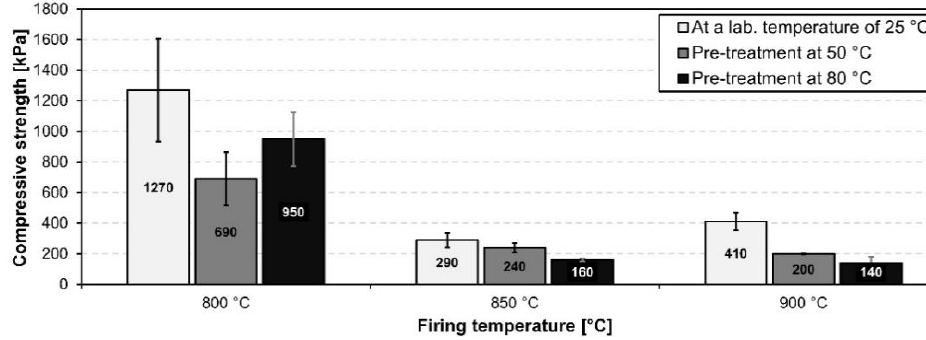
Figure 10. Compressive strength of prepared foam samples fired at different temperatures.